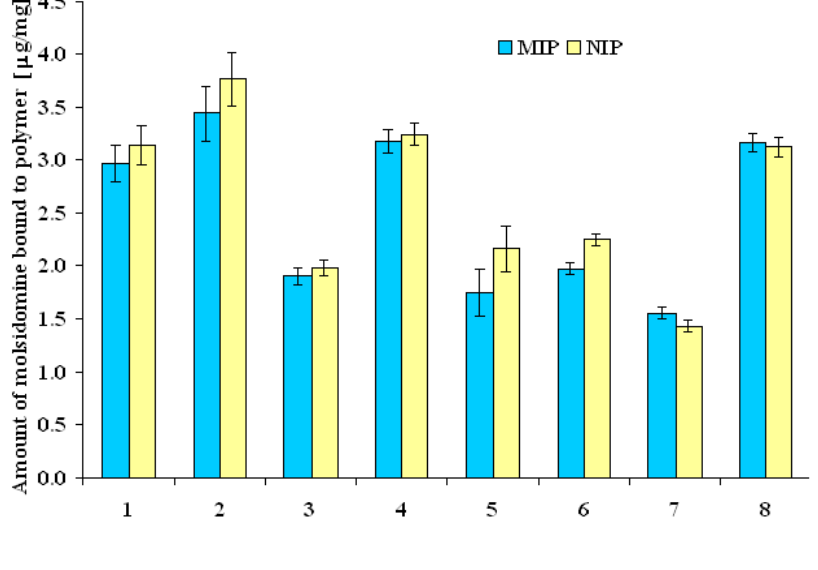
Figure 3 . The amount of molsidomine bound to polymers in aqueous media.